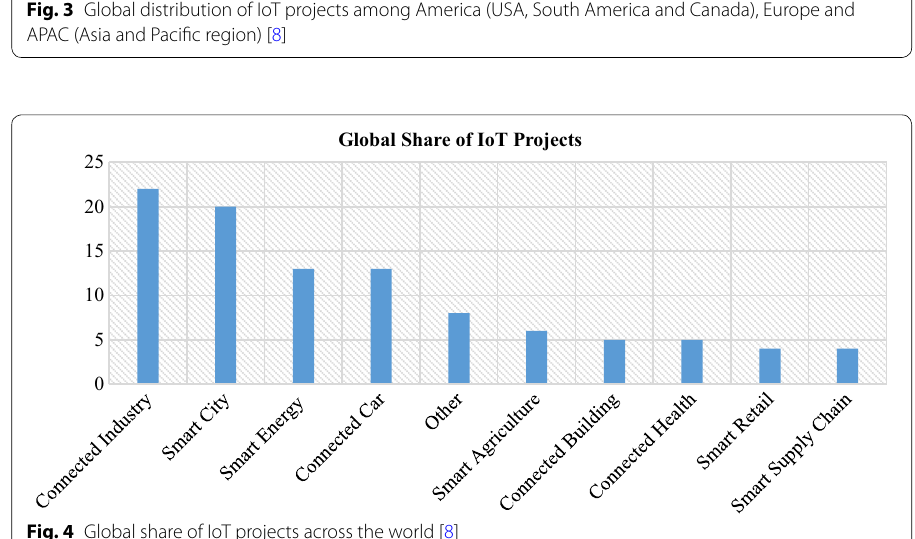
Fig. 4 Global share of IoT projects across the world